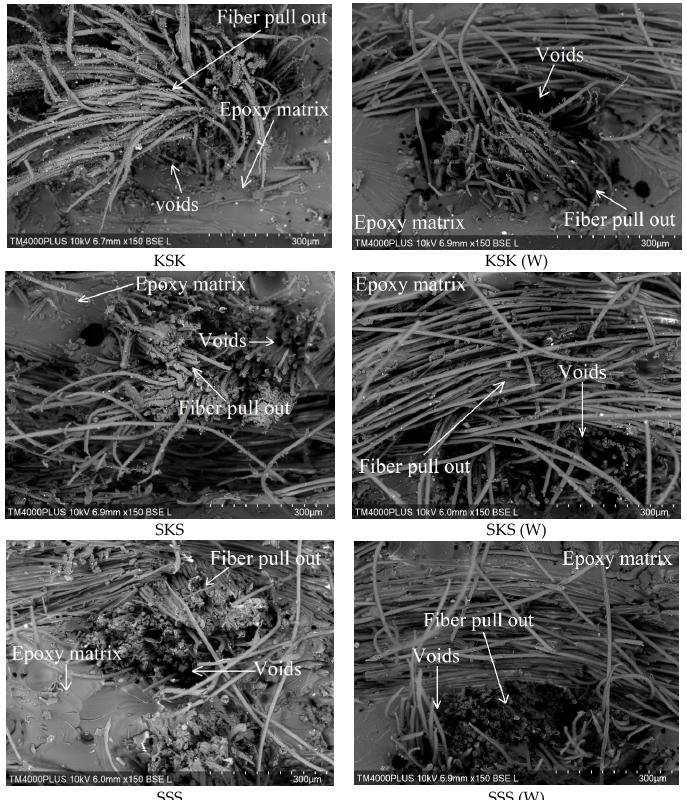
Figure 4. SEM micrographs of the tensile fracture samples before and after